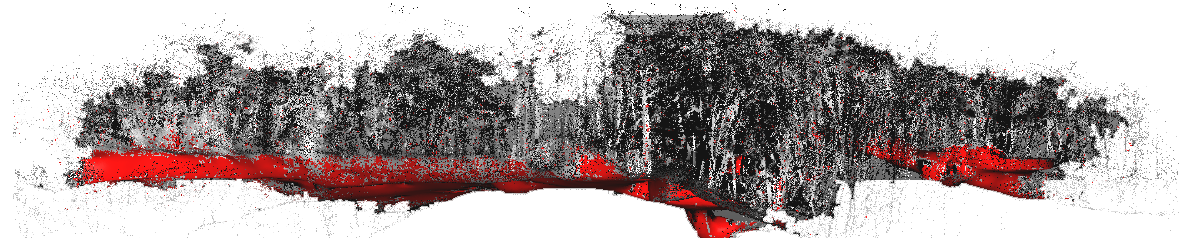
Figure 8: Point cloud classification to distinguish man-made military structures (red) from vegetation areas (grey) (Farella,